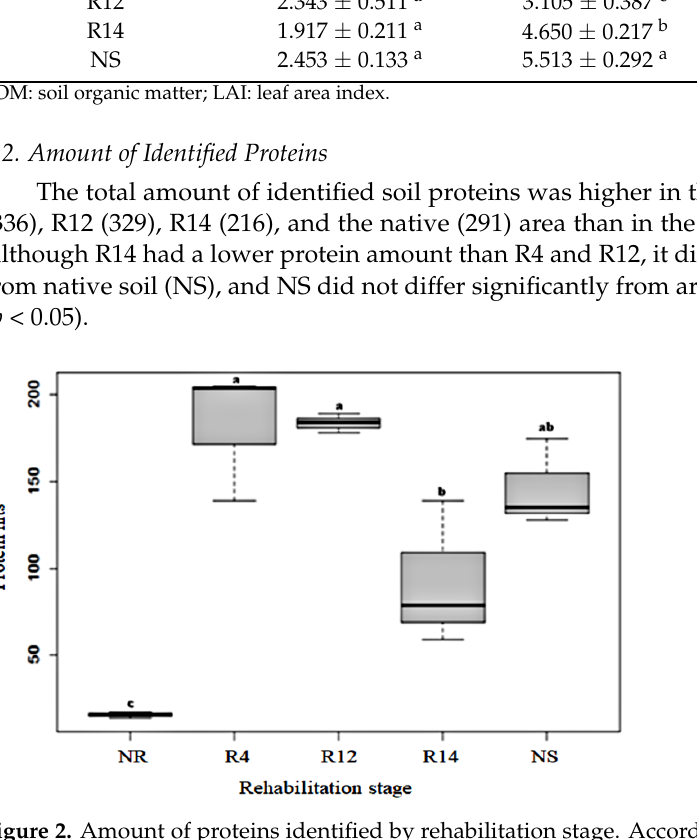
Figure 2. Amount of proteins identified by rehabilitation stage. According to the Tukey test, data followed by the same letter do not differ significantly ( p < 0.05).